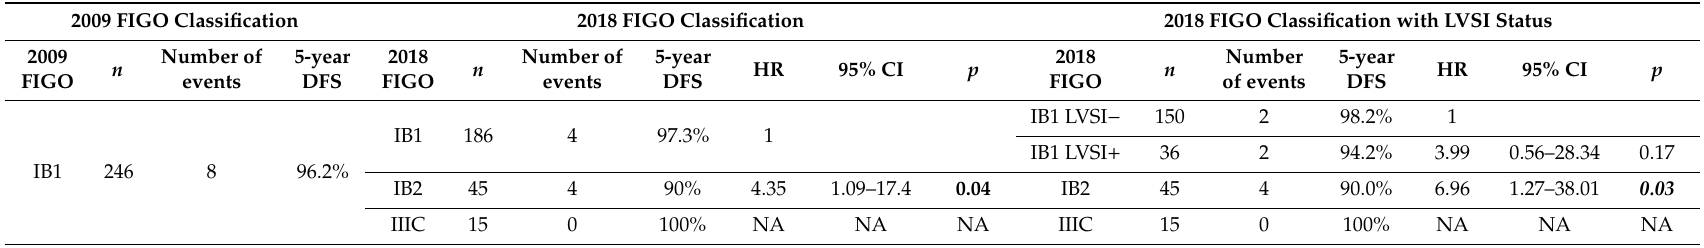
Table 4. Cox proportional Hazards models of 5-year Disease-specific survival according to the 2009 FIGO and the revised 2018 FIGO staging